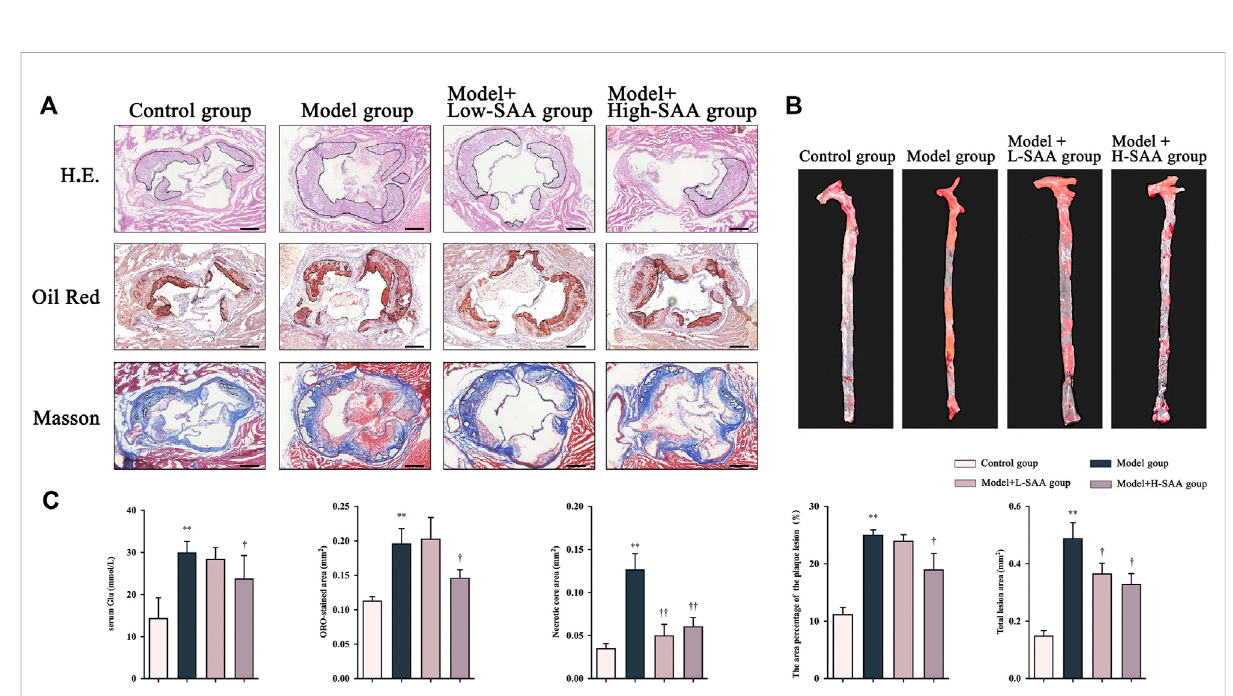
SAA attenuated the formation of atherosclerotic lesions in Western diet-fed diabetic ApoE − / − mice. (A) Representative H.E. staining, oil red staining and Masson Trichrome staining of sectioned aortic roots (n = 4 ). (B) Representative oil red O staining of en face aorta (n = 4 ). (C) The content of serum glucose in